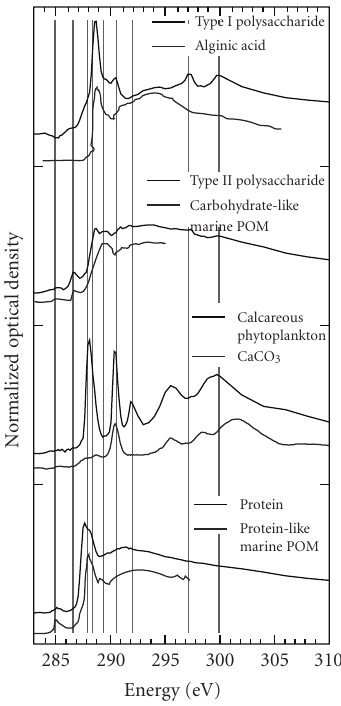
Figure 3: Normalized average spectra for each of the four marine particle types and (below) corresponding reference spec- tra with similar features. Spectra were reproduced from [41] (alginic acid), [38] (carbohydrate and protein-like marine POM), and http://xray1.physics.sunysb.edu/ ∼ micros/xas/xas.html, unpub- lished (CaCO 3 ). Vertical grey lines mark relevant transitions (from left to right): 285eV (R(C = C)R (cid:3) ), 286.7 eV (R(C = O)R (cid:3) ), 288.1 eV (R(C–H) n R (cid:3) ), 288.3 eV (R–NH(C = O)R (cid:3) ), 289.5 eV (R– COH), 290.4 eV (CO 32 − ), 292 eV (R(C–H) n R (cid:3) ), 297.4 eV (K), and 299eV